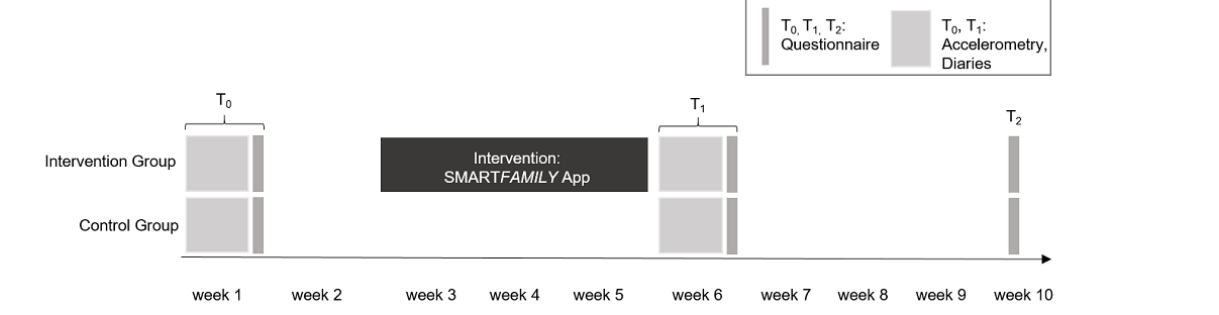
Participants allocated to the intervention group